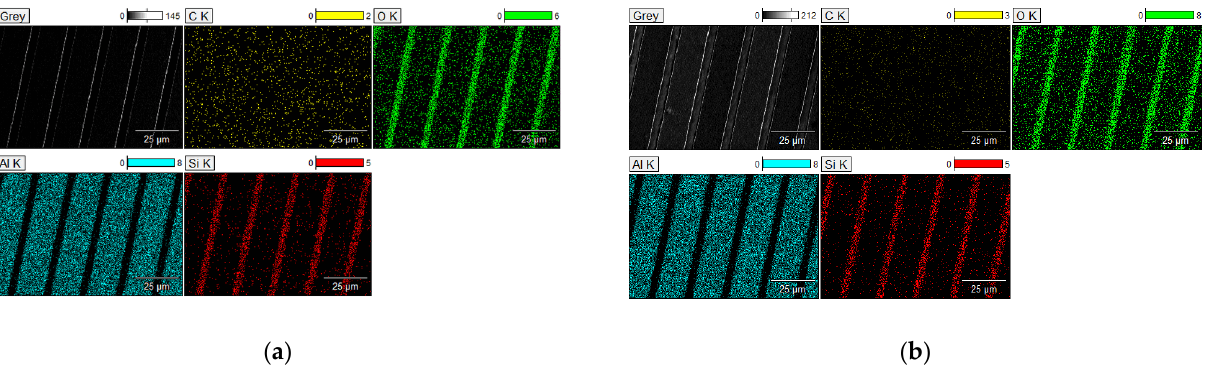
Figure 6. SEM EDS characterization: ( a ) Non-activated Al surface; ( b ) Activated Al surface. Table 1 gives the percentage of counts for various elements found on the chip’s surface.